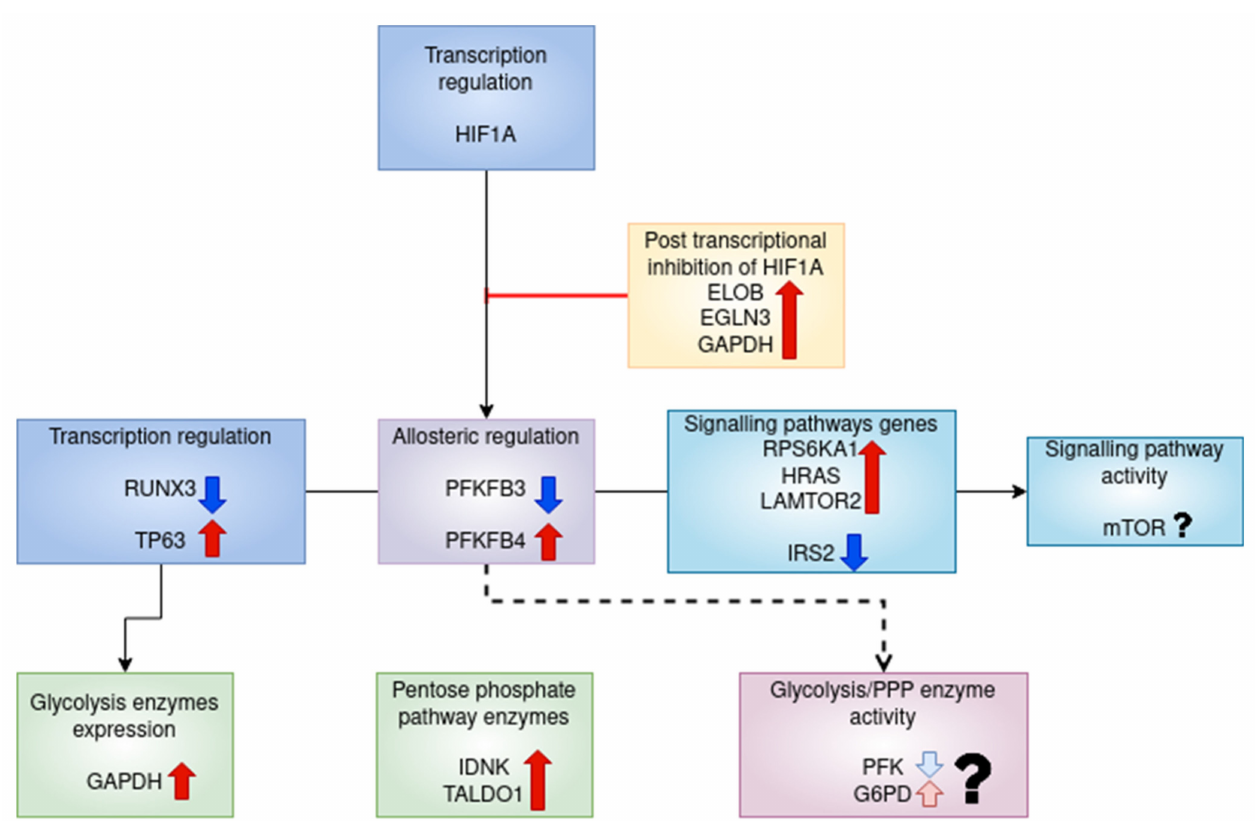
Figure 20. The differentially regulated genes involved in the regulation of glycolysis in RA CD8 + Tem cells. Post transcriptional inhibition of HIF1A by the upregulated ELOB , EGLN3 and GAPDH (red up arrow) inhibits HIF1A activity resulting in the downregulation of PFKFB3 (blue down arrow). This causes reduced activity of the glycolytic enzyme PFK (light blue down arrow) and increased activity of the pentose phosphate pathway enzyme G6PD (light red up arrow). The upregulated transcription factor TP63 (red up arrow) causes increased expression of GAPDH (red up arrow). IRS2 is downregulated (blue down arrow), while RPS6KA1 , HRAS and LAMTOR2 are upregulated (red up arrow) upstream of mTOR. The effect of these changes in mTOR cannot be determined in this study (question mark). The pentose phosphate pathway genes, IDNK and TALDO1 , are also upregulated (red up